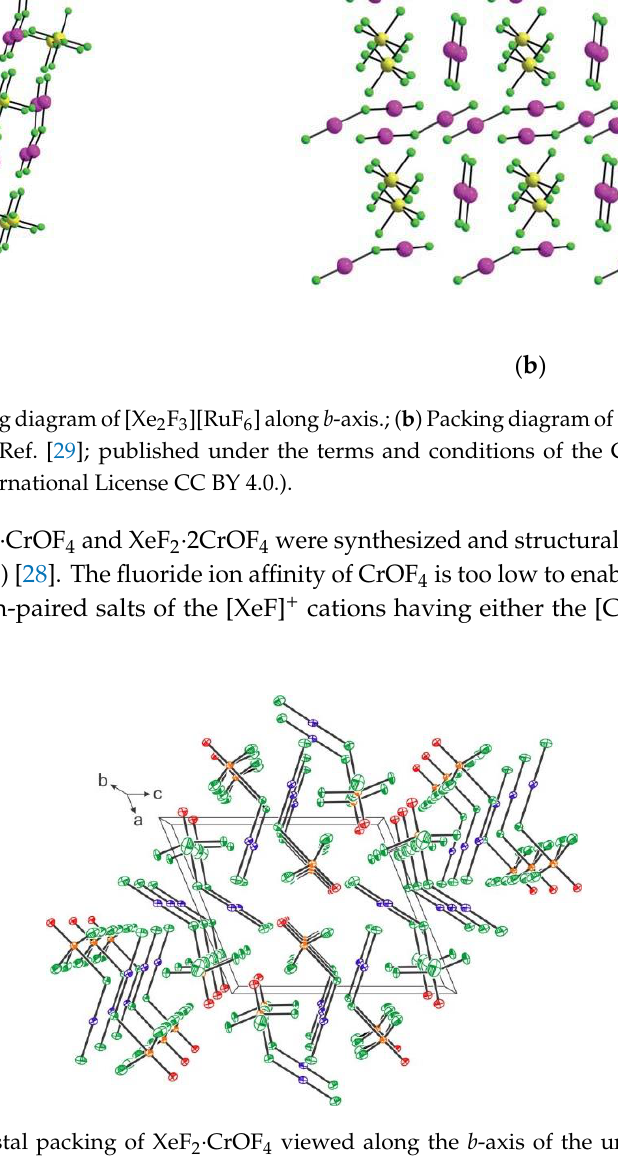
Figure 2. The crystal packing of XeF 2 ∙CrOF 4 viewed along the b -axis of the unit cell. Copyright (2019) Wiley. Used with permission from Ref. [28].